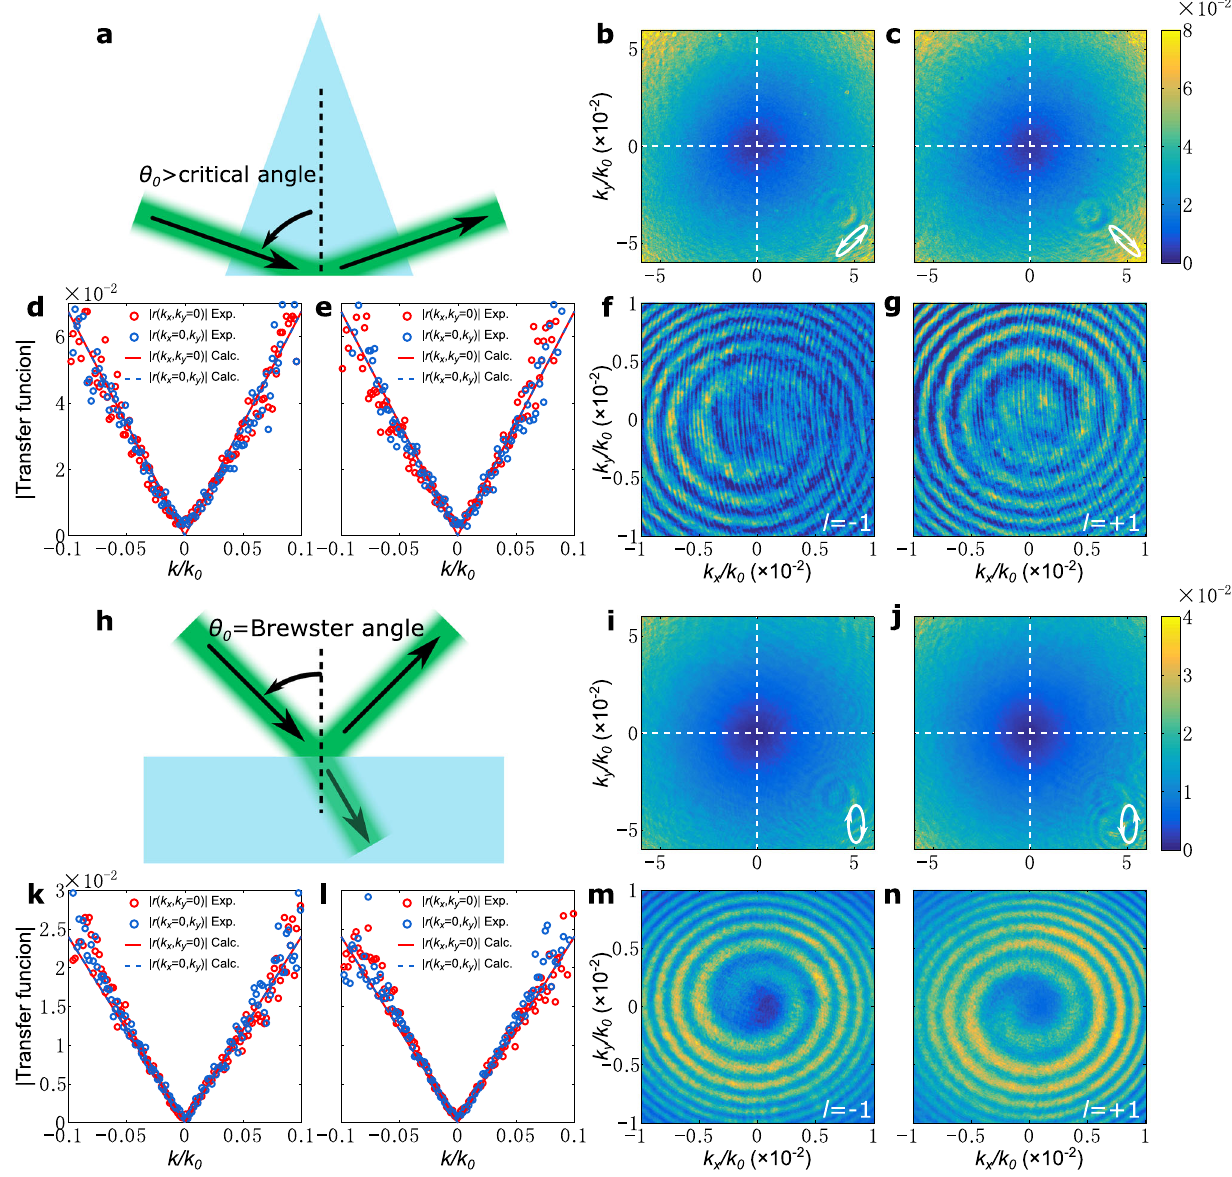
Fig. 2 Measured magnitudes of transfer functions and corresponding topological charges. a Schematic of the total internal re fl ection setup with θ 0 = 70.24 ∘ . b , c Measured magnitudes of transfer functions, as a function of transverse wavevectors, using the setup in ( a ) with γ = − π /4 and γ = + π /4, respectively. The corresponding incident polarizations are shown as the insets. d , e The scatter plots are the data on the dashed lines in ( b , c ), respectively, and the lines are the corresponding calculated magnitudes of transfer functions. k in the horizontal axes is the magnitude of the wavevector. f , g The interference fringe patterns of an output beam with a divergent beam corresponding to ( b , c ), respectively. The insets show the topological charges. h Schematic of the setup for operating at the Brewster angle with θ 0 = 56.64 ∘ and γ = π /2. i , j Measured magnitudes of transfer functions, as a function of transverse wavevectors, using the setup in ( h ) with the input polarizations shown as the insets. k , l The scatter plots are the data on the dashed lines in ( i , j ), respectively, and the lines are the corresponding calculated magnitudes of transfer functions. k in the horizontal axes is the magnitude of the wavevector. m , n The interference fringe patterns of an output beam with a divergent beam corresponding to ( i , j ), respectively. The insets show the topological Figure 2b, c are the measured magnitudes of the transfer functions. Speci fi cally, Fig. 2b is measured with the output polarizer orientation γ = − π /4 and the input polarization ffiffiffi p ¼ ð r ; r Þ T = e 2 , as determined using Eqs. (5), (9a) and s 0 p 0 in (9b) for the case of C y / C x = − i . Figure 2c is measured with output polarization orientation γ = + π /4 and incident polarization ffiffiffi p ¼ ð r ; (cid:3) r Þ T = e 2 , corresponding to the case of C y / C x = + i s 0 p 0 in in Eqs. (9a) and (9b). In both Fig. 2b, c, the measured magnitudes